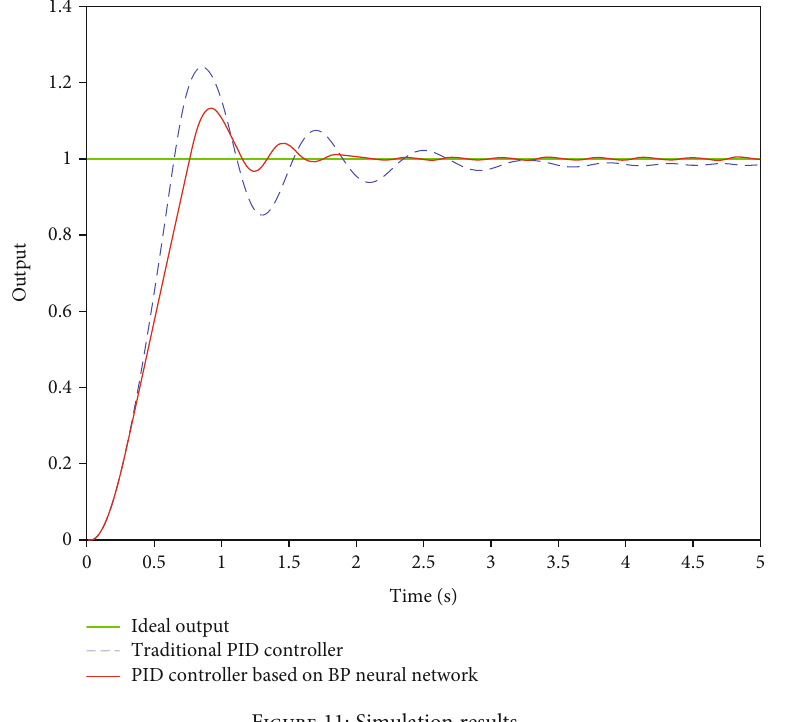
Figure 11: Simulation results.